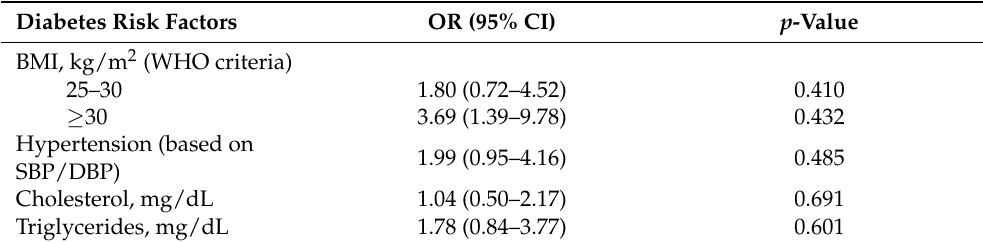
Table 6. Trinidadian adults’ diabetes score in the Trinidadian diabetes dataset (71 diabetes cases, n = 121, AUC=